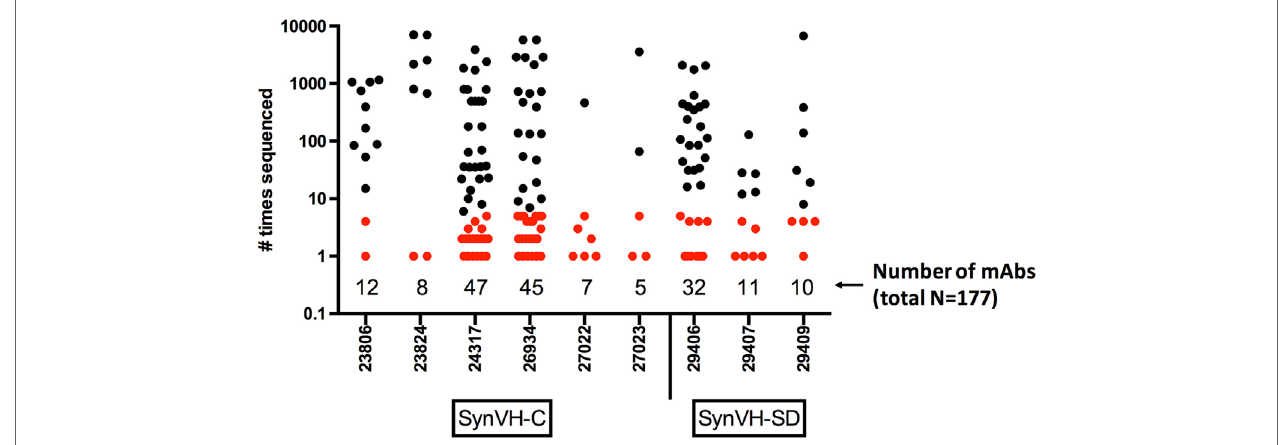
FigUre 7 | Frequency of mAb sequences in NGS data show that many mAbs identified by gel-encapsulated microenvironment (GEM) screening are rare in the spleen population. Number of times each antigen-specific mAb sequence identified in GEM screens was found in all of the sequencing data from each bird. The mAbs are grouped by bird and transgene, either SynVH-C or SynVH-SD, as indicated. The number of mAbs from each bird is indicated below the plots. mAbs that were sequenced five or fewer times in the whole dataset are colored red, showing that rare mAbs are found in the GEM